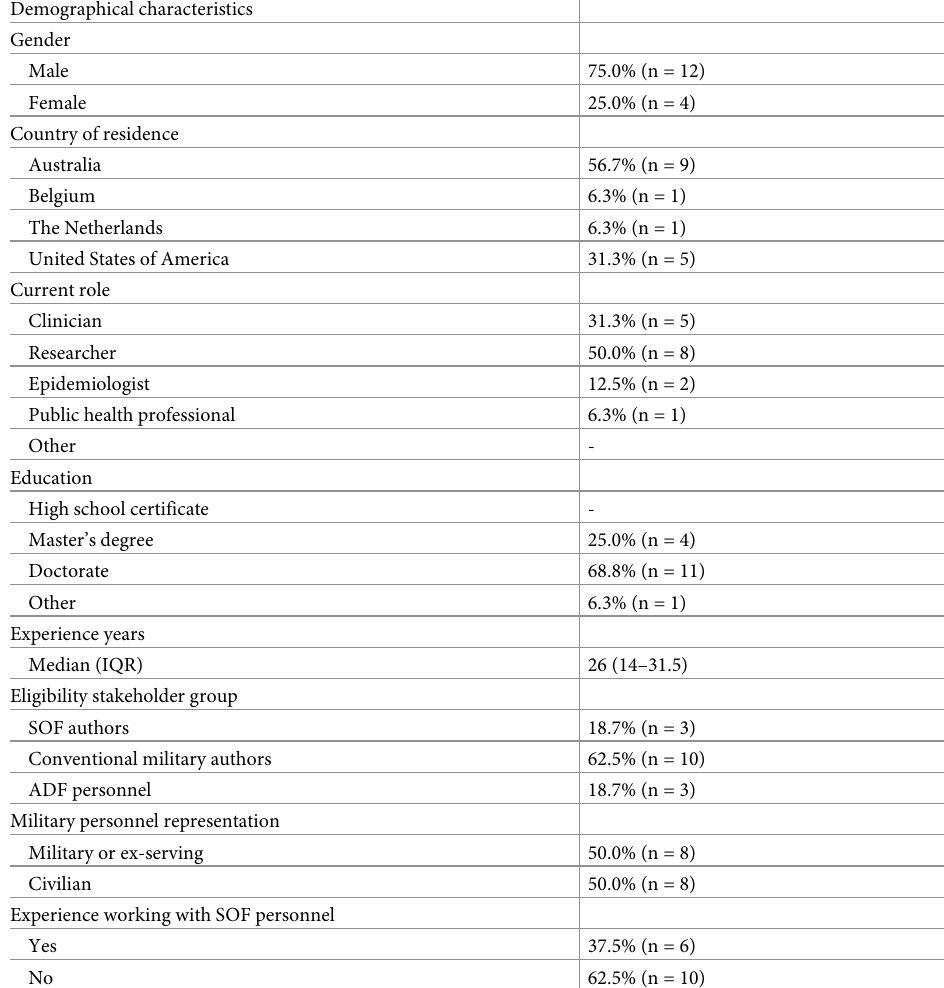
Table 1. The demographic and experience profile of the experts participating in the Delphi rounds (n =